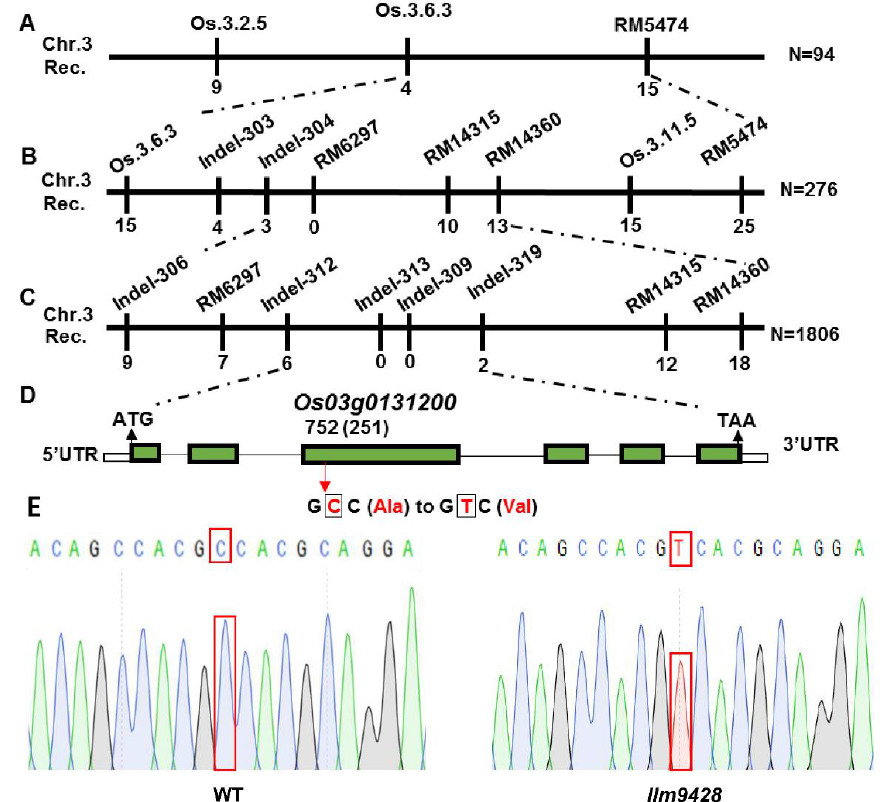
Figure 6. Gene mapping of candidate gene of llm9428. ( A ) The position of the candidate gene of llm9428 on chromosome 3 between SSR marker Os.3.6.3 and RM5474, ( B ) The further narrowed down region of the candidate gene of llm9428 between Indel marker RM14360 and Indel-304, ( C ) The further narrowed down region of the candidate gene of llm9428 between Indel marker Indel-312 and Indel-319, ( D ) The structure of the candidate gene, which has six exons and five introns are indicated by green rectangles and black lines respectively. ( E ) Chromatograms showing the sequence comparison of WT and llm9428.